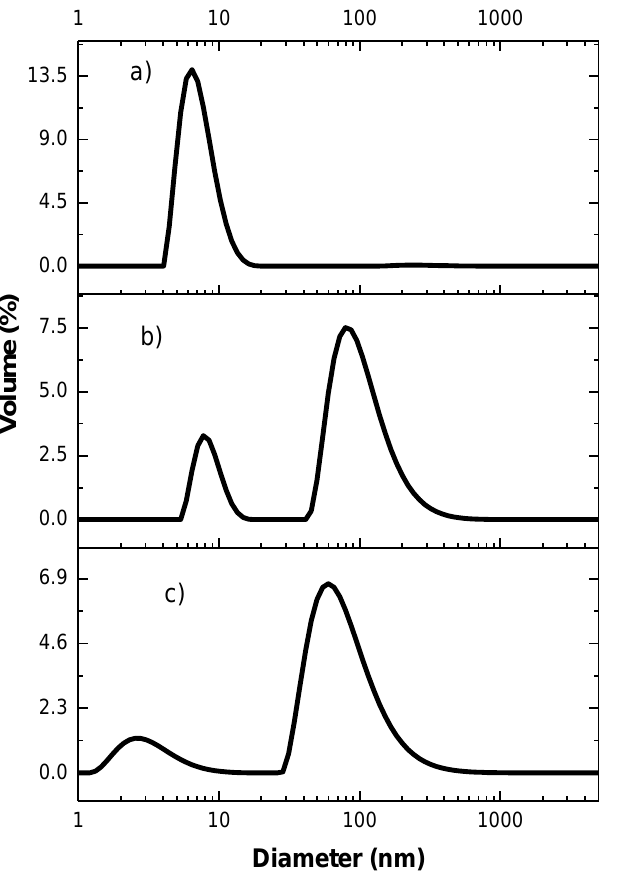
Figure 8. DLS volume size distribution at room temperature of TEGMA- ran -FA encapsulating CA- 4 in a 30/1 weight ratio ( a ), PEGMA- ran -FA encapsulating CA-4 in 19/1 ( b ), and 30/1 weight ratios ( c